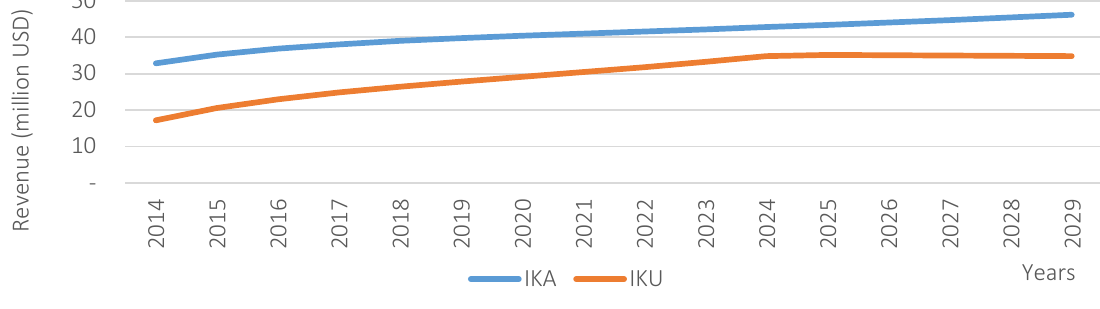
Figure 4. Simulation graphic of IKA and IKU in scenario 1.3 Table 6. Combination of scenario 3.2 with sub-